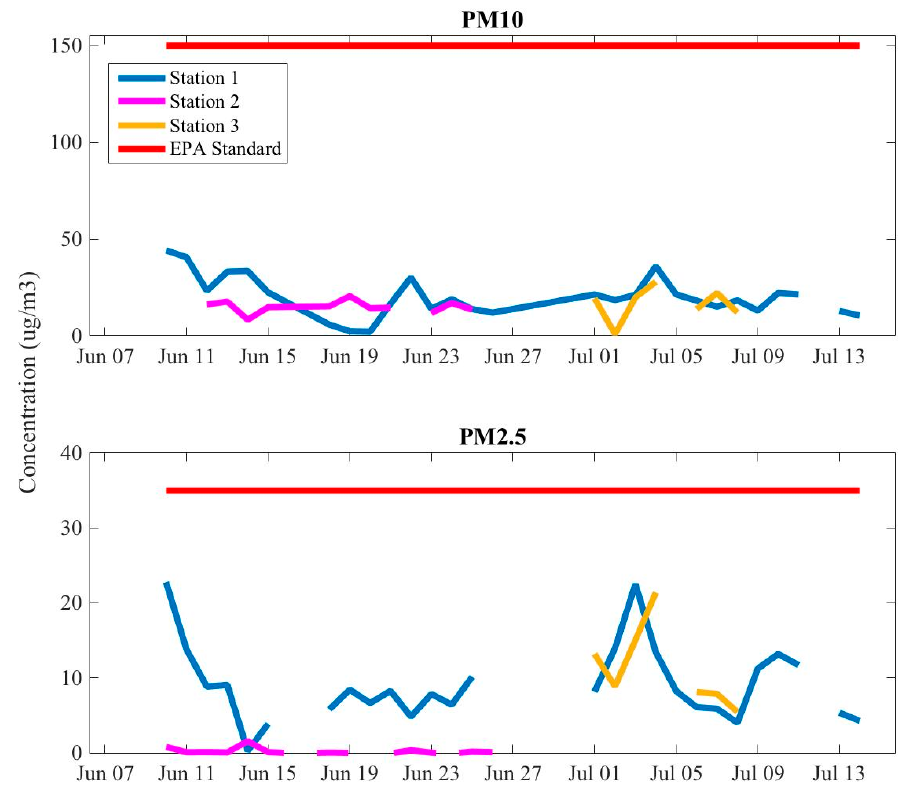
Figure 3. The daily 24-hour concentration of PM 10 and PM 2.5 at Station 1 (blue), Station 2 (magenta) and Station 3 (gold) plotted against the US EPA National Ambient Air Quality Standards value for 24-hour average PM 10 concentration (red).